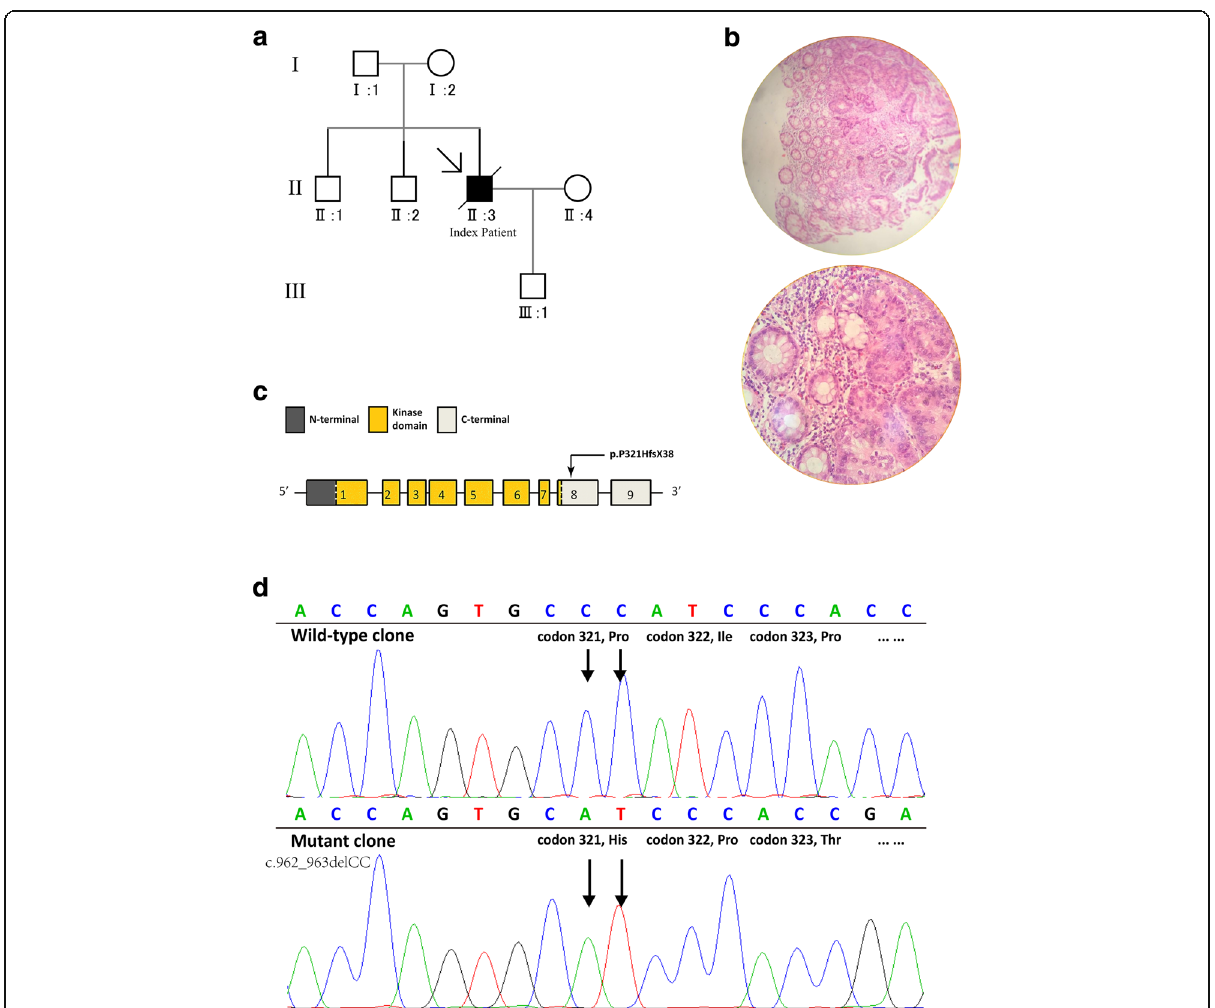
Fig. 1 Genogram, pathology and electropherogram of the index patient. a The genogram showed an isolated PJS patient. Roman numerals indicate generations and Arabic numbers indicate individuals. Squares = males, circles = females. Affected individuals are denoted by solid symbols and unaffected individuals are denoted by open symbols. The index patient is indicated by an arrow. b Representative hematoxylin-eosin-stained tissue slices of the GI polyp biopsy specimens showed carcinoma infiltration. Up, ×100 magnification; low, ×400 magnification. c The structure of STK11 gene. This novel mutation is within exon 8. d Sanger sequencing with the help of T vector assay revealed a heterozygous frameshift mutation, c.962_963delCC